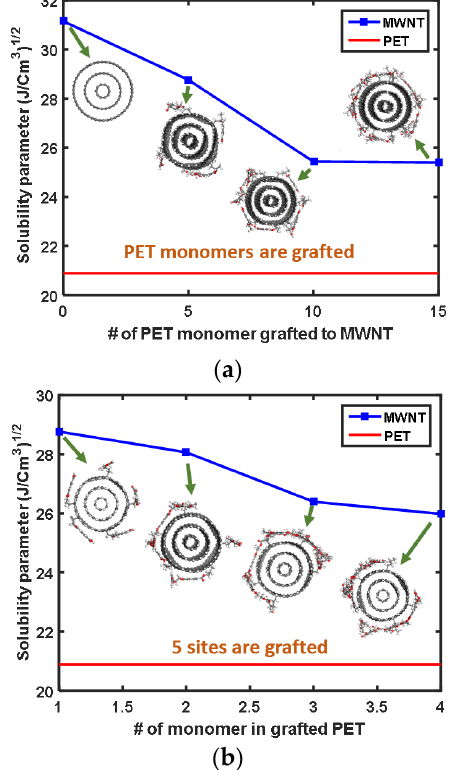
Figure 10. Hildebrand solubility parameters for MWNT and PET obtained by varying the ( a ) number of surface-functionalized ethylene terephthalte monomer and ( b ) number of PET monomer groups on the grafted PET moieties.